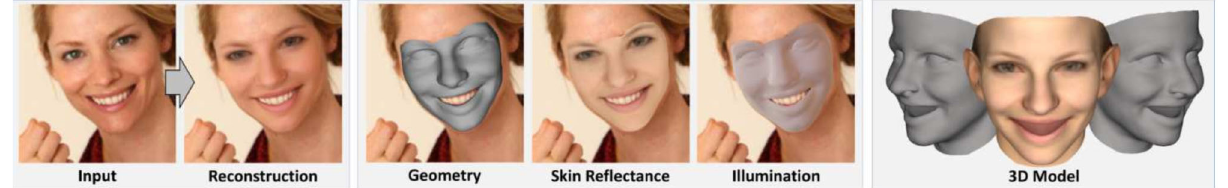
Fig. 4 Model-based neural network for unsupervised monocular reconstruction. The proposed face autoencoder enables unsupervised end-to-end learning of semantic parameters including geometry, illumination, expression, etc. Reproduced with permission from Ref. [64], c (cid:2) Institute of Electrical and Electronics Engineers